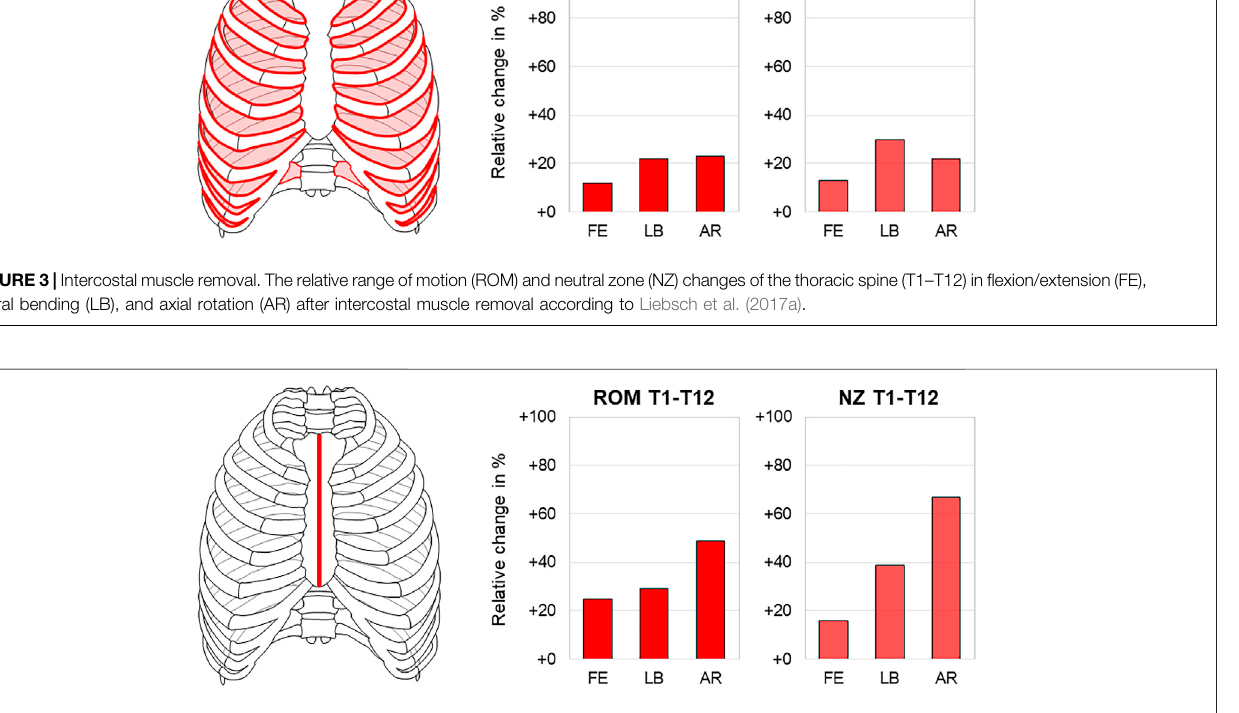
FIGURE 4 | Longitudinal sternal transection. The relative range of motion (ROM) and neutral zone (NZ) changes of the thoracic spine (T1 – T12) in fl exion/extension (FE), lateral bending (LB), and axial rotation (AR) after longitudinal sternal transection according to Liebsch et al. (2017a) and Liebsch et al. (2017b).